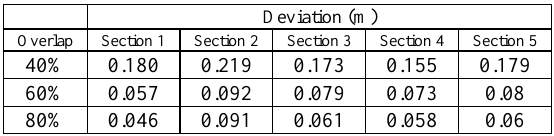
Table 2. Average deviations of the component along z axis of the photogrammetric point clouds from the reference TLS one.